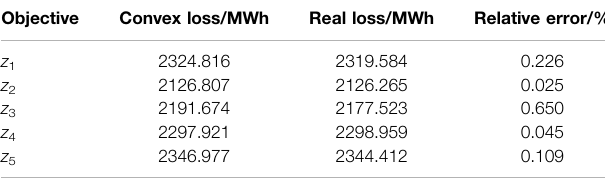
Figure B1 . The units included two PSH units, six coal- fi red